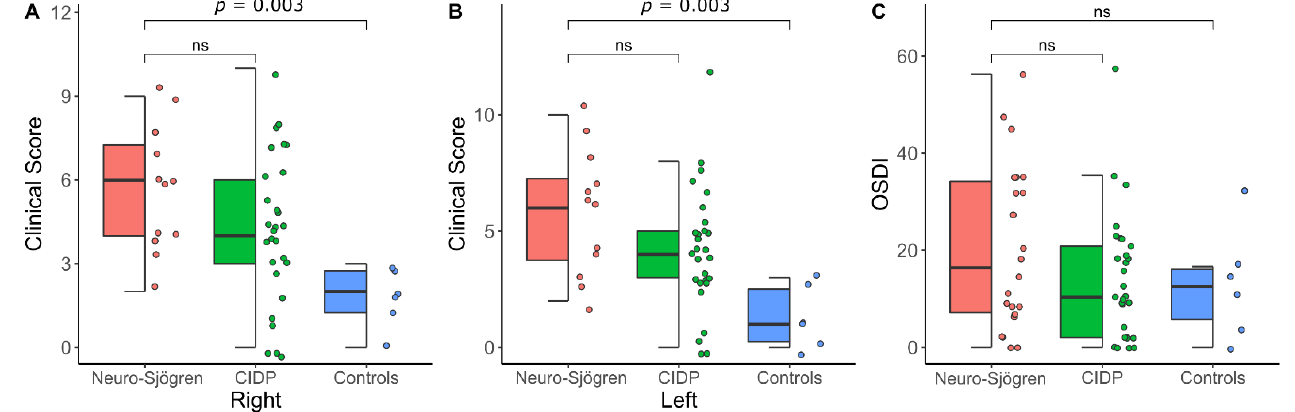
Figure 3. Results of the Clinical Evaluation of dry eye symptoms and signs with significance levels at in-between group differences for patients with Neuro-Sjögren (red), chronic inflammatory demyelinating polyneuropathy (CIDP, green) and controls (blue): clinical score of the dry eye for the right ( A ) and left side ( B ); ocular surface disease index (OSDI, C ); ns: not significant. Table 4. Correlation analysis for the full cohort between parameters of the corneal confocal microscopy and the clinical evaluation of dry eye symptoms and signs with significance levels (green color- significant group